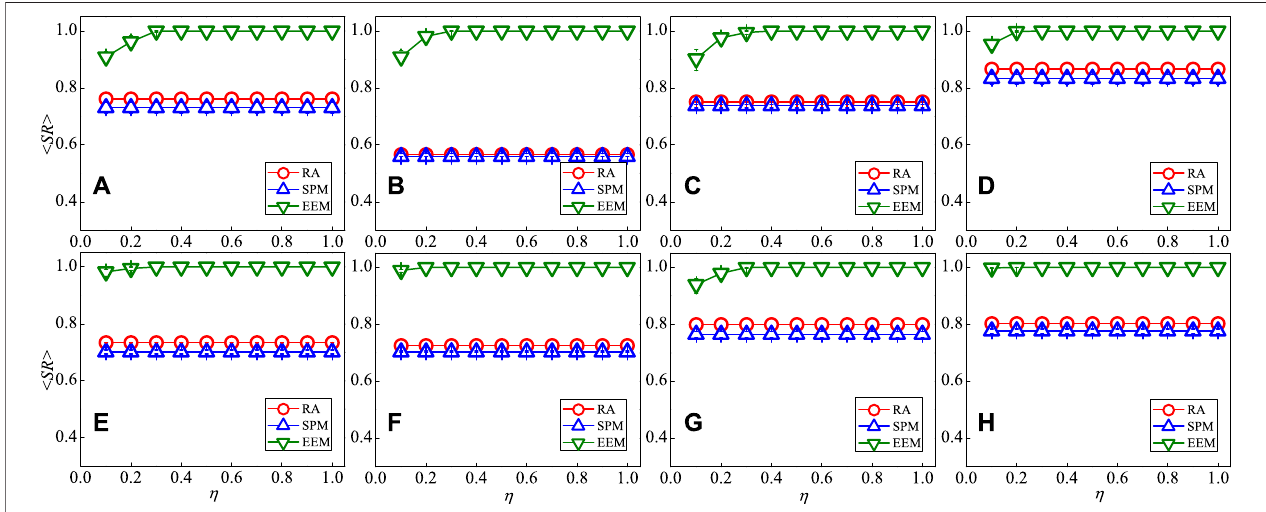
FIGURE 2 | (Color Online) The mean success rates of existent links 〈 SR 〉 of reconstructing four types of networks: (A) small-world network with 120 nodes, (B) random network with 120 nodes, (C) regular network with 120 nodes, (D) Apollonian network with 124 nodes, (E) small-world network with 250 nodes, (F) random network with 250 nodes, (G) regular network with 250 nodes, (H) Apollonian network with 367 nodes, hosting a PDG dynamical process. The lines with circle, triangle and inverted triangle symbols are the mean success rates of existent links 〈 SR 〉 obtained by RA, SPM and EEM based on 90% priori structure information. The mean reconstruction accuracy indices are achieved by averaging over 50 independent experimental results. For each experiment, measurements are randomly picked from a time series of temporary evolution. The index of information suf fi ciency rate η indicates the amount of the available time-series information used in the reconstruction. The payoff parameter for the PDG is b (cid:1)